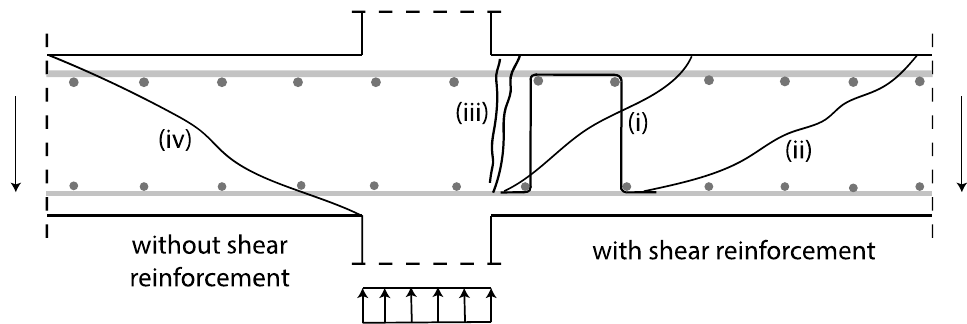
Figure 1. Scheme of the typical crack formations of punching shear failure modes: ( i ) inside and ( ii ) outside the zones of punching shear reinforcement, ( iii ) at maximum punching shear capacity and ( iv ) without punching shear reinforcement (adapted from [2]).